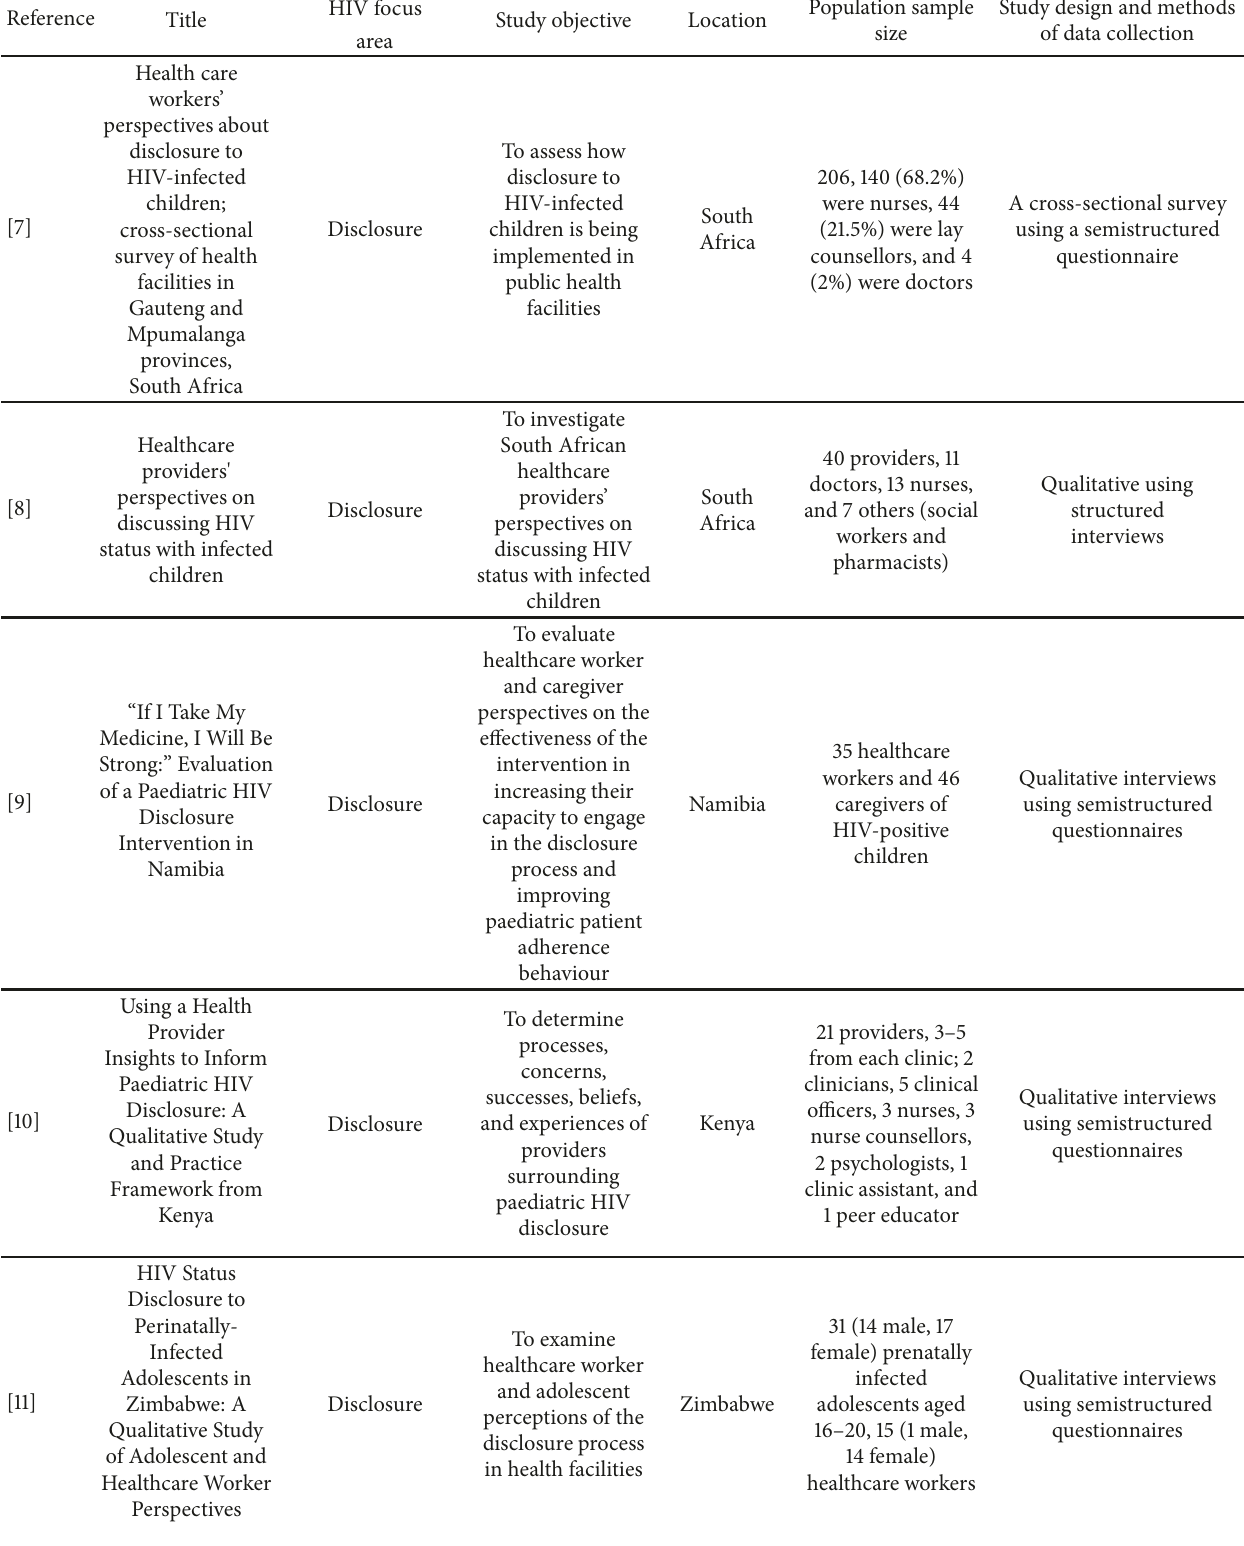
Table 1: A summary of the studies